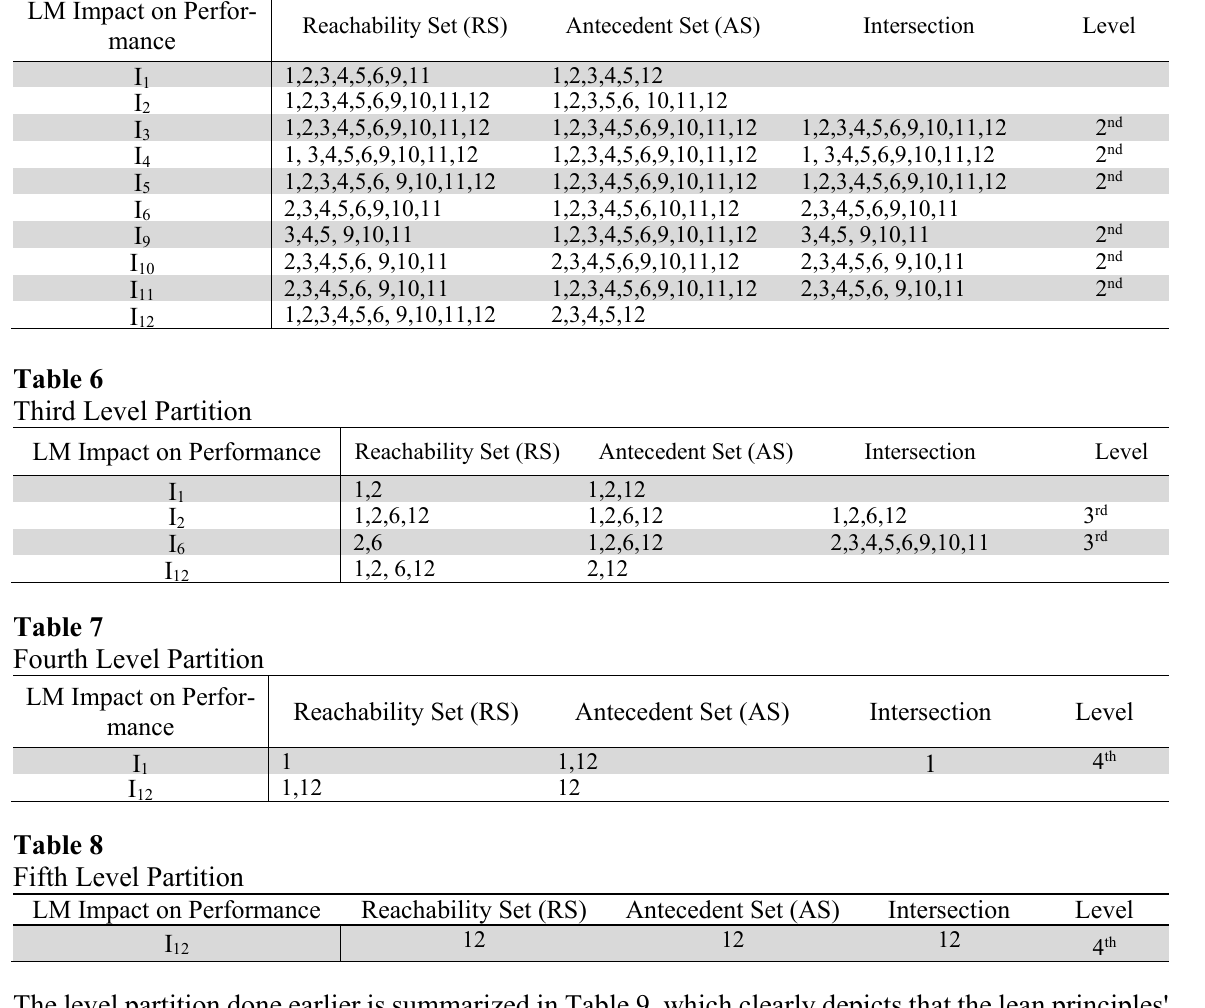
Second Level Partition LM Impact on Perfor-